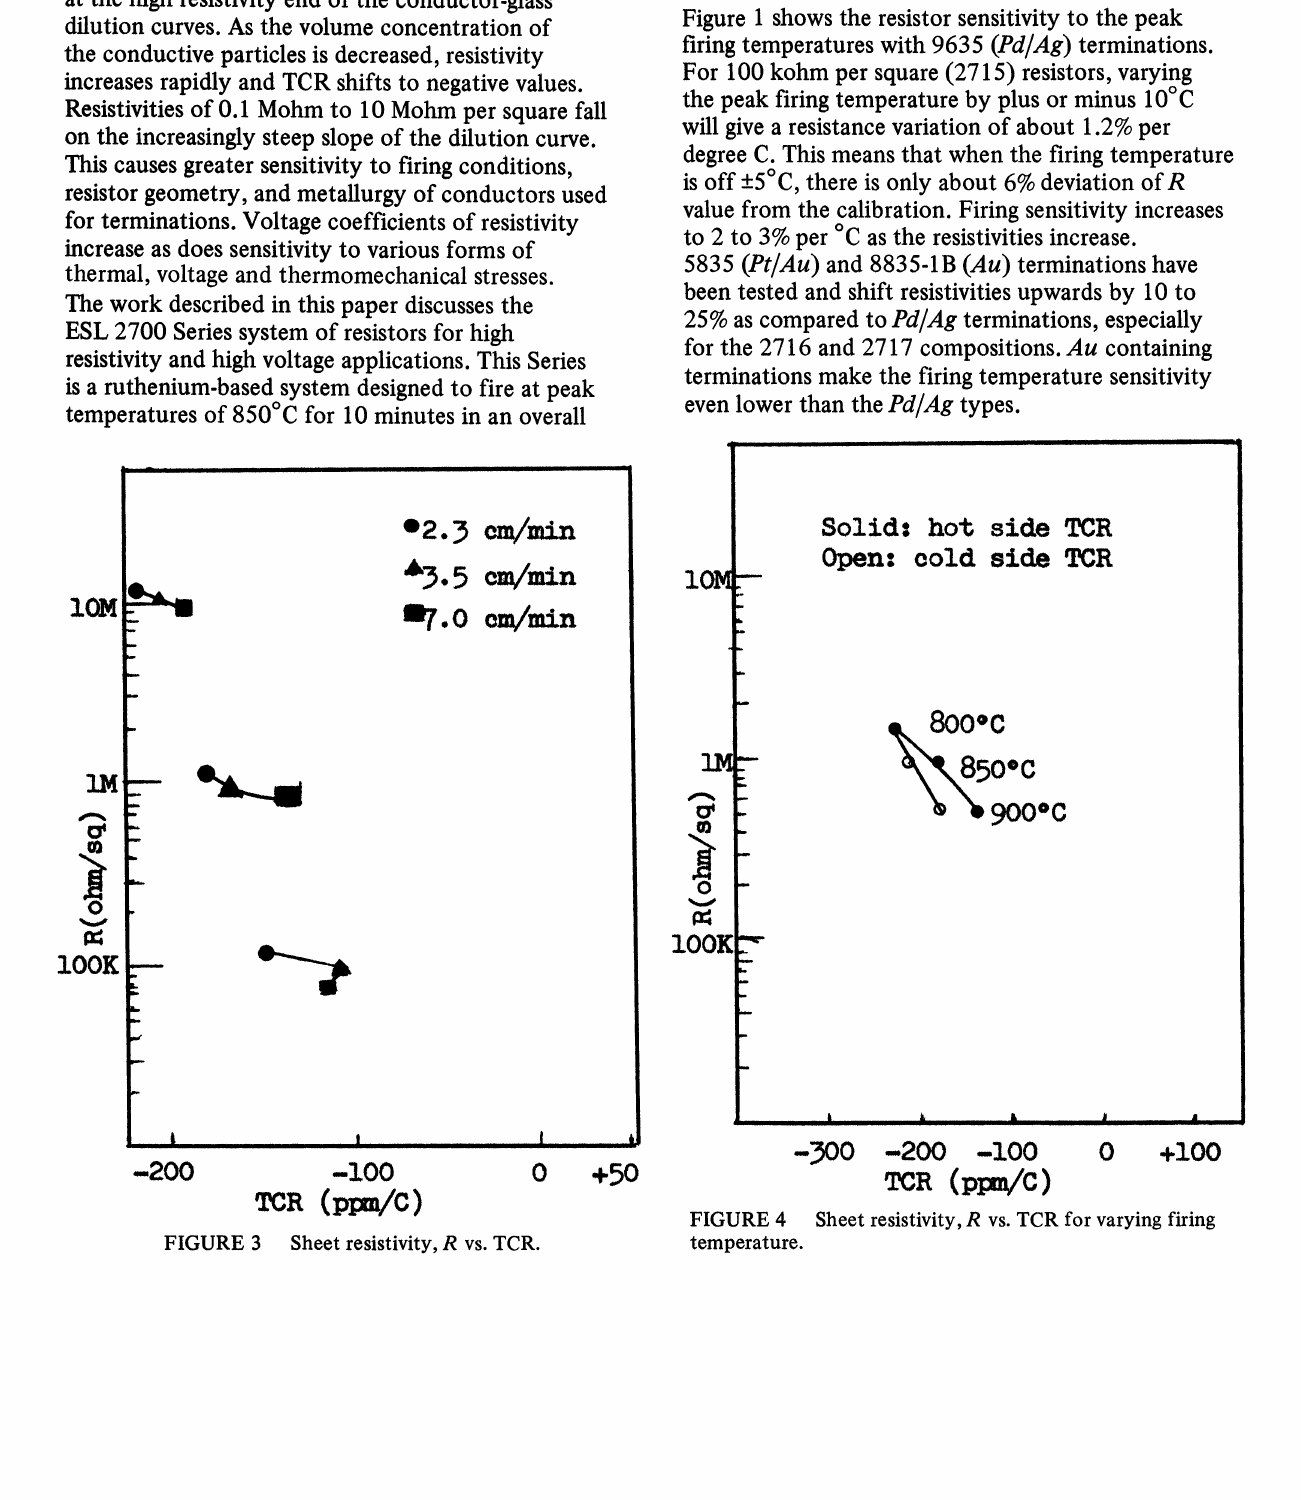
FIGURE 3 Sheet resistivity, R vs. TCR.